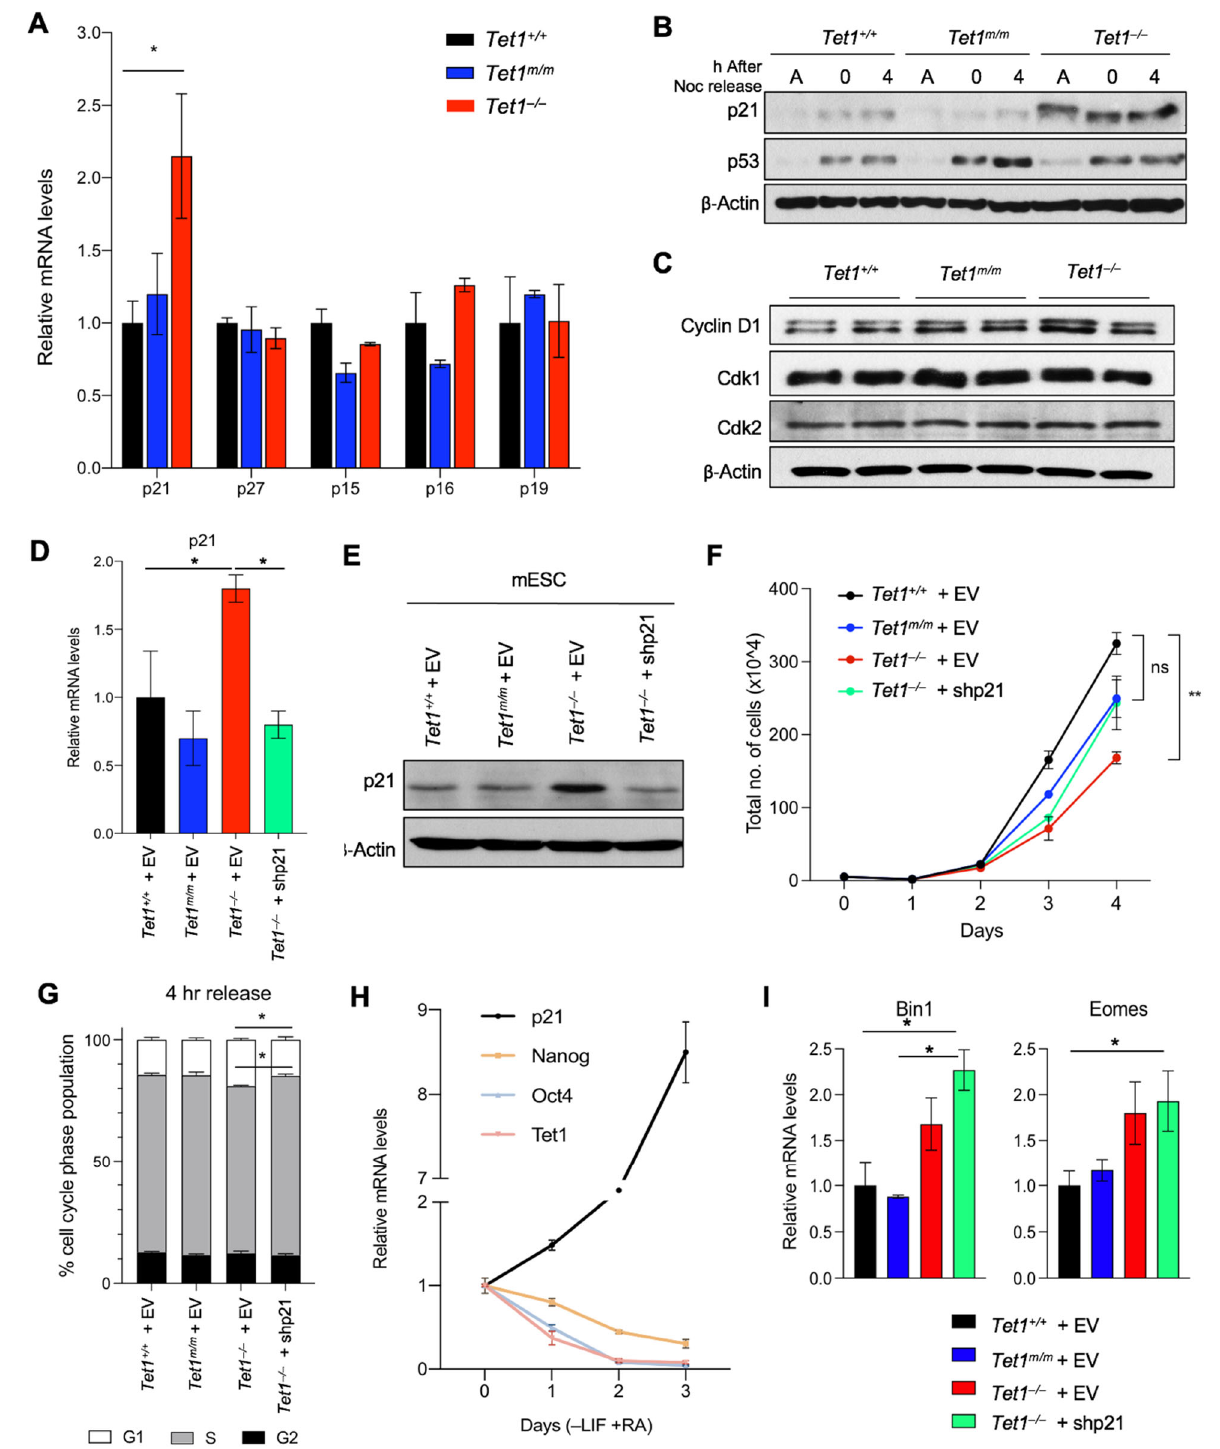
Figure 2. Aberrant upregulation of p21 is responsible for the slow proliferation of Tet1 − / − mESCs. ( A ) Quantification of p21, p27, p15, p16 and p19 mRNA levels in mESCs of indicated genotypes by RT ‐ qPCR. Data normalized to Gapdh expression. Three lines of each genotype were used. ( B ) Quan ‐ tification of p21 and p53 protein levels in asynchronous ( A ), G2/M ‐ arrested (0 h) and released (4 h) mESCs of indicated genotypes by Western blot analysis. β‐ actin was used as a loading control. ( C ) Quantification of Cdk1, Cdk2 and Cyclin D1 protein levels in asynchronous mESCs of indicated genotypes by Western blot. β‐ actin was used as a loading control. ( D – E ) Quantification of p21 mRNA levels by RT ‐ qPCR ( D ) and protein levels by Western blot ( E ) in Tet1 +/+ , Tet1 m/m , Tet1 − / − mESCs transduced with empty vector (EV) or an shRNA against p21 vector (shp21). ( F ) Growth curve of